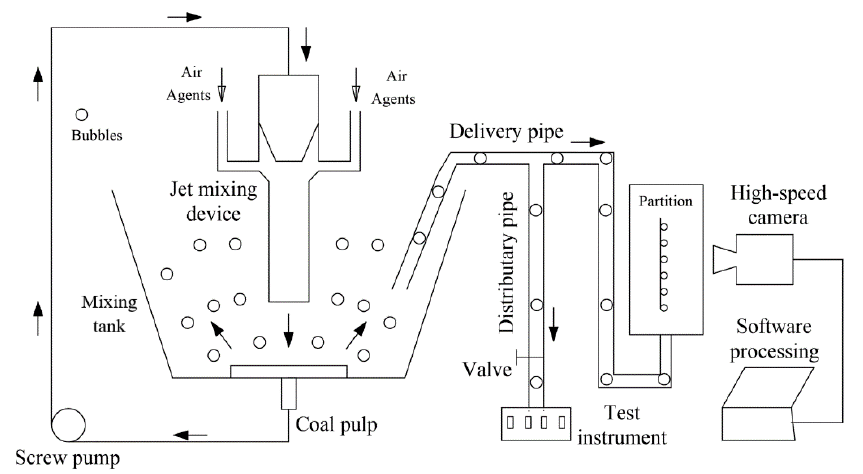
Figure 1. Test system.